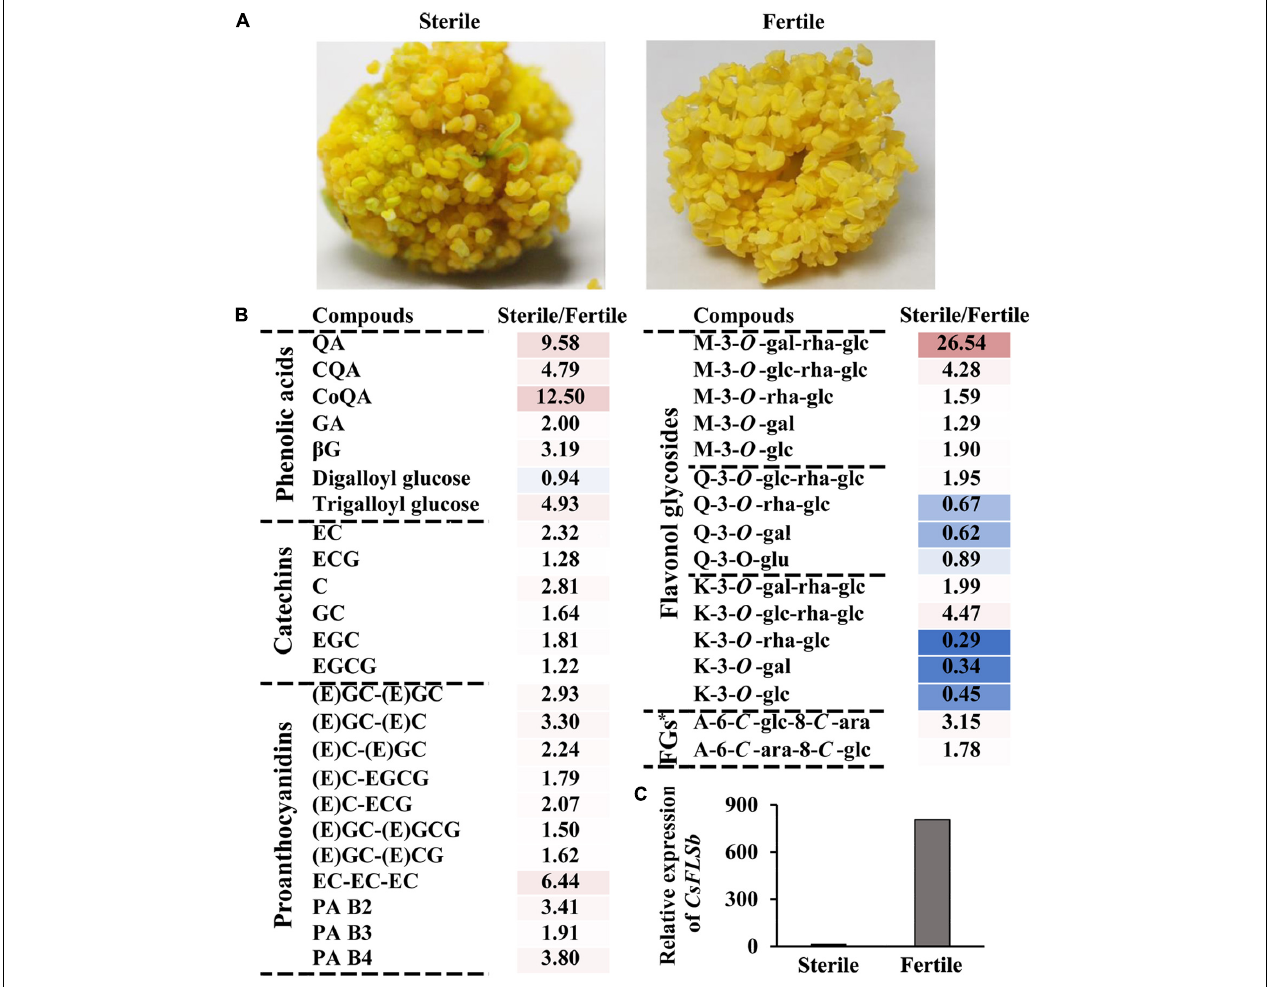
FIGURE 4 | Characteristics of phenolic compound accumulation in the anthers of hybrid sterile and fertile tea flowers and CsFLSb gene expression in hybrid sterile and fertile flowers. (A) Anther phenotypes of the hybrid sterile flower with no pollen and fertile flowers. (B) Metabolic analysis of phenolic compounds between hybrid sterile anther and fertile anther. FGs*, Flavone glycosides. (C) CsFLSb expression in hybrid sterile and fertile flowers; the histogram shows the FPKM values.